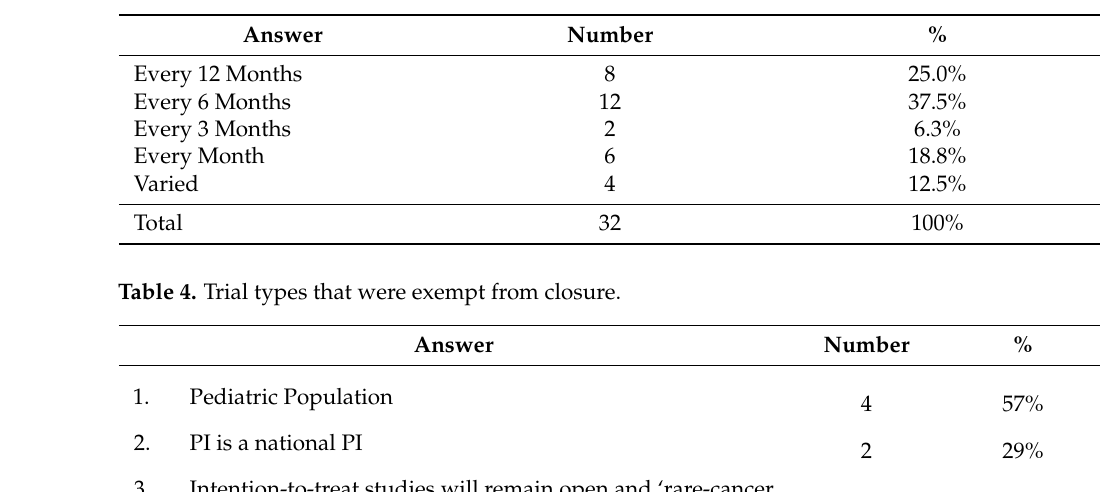
Table 3. Frequency of PRMC accrual monitoring.